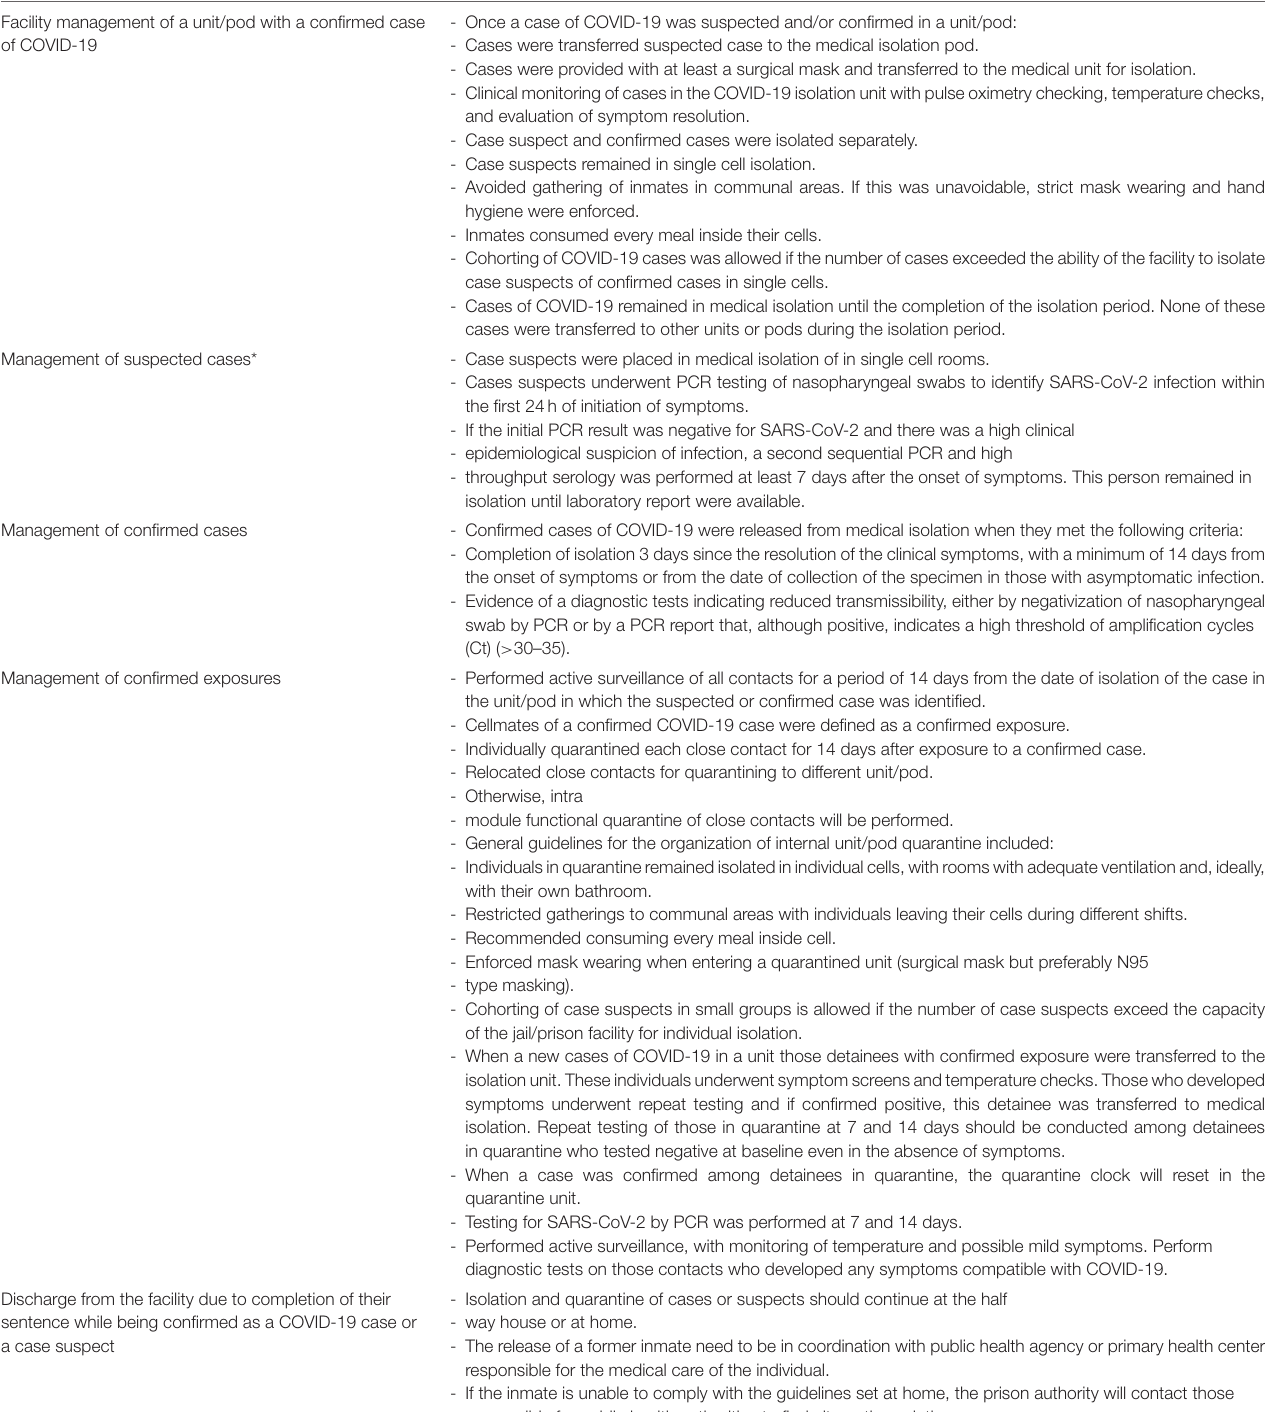
TABLE 3 | Interventions implemented for the management of confirmed cases and close contacts during the COVID-19 outbreak in the CPAII Prison in Alicante, Spain (January-April 2021). Facility management of a unit/pod with a confirmed case - Once a case of COVID-19 was suspected and/or confirmed in a unit/pod: of COVID-19 - Cases were transferred suspected case to the medical isolation pod. - Cases were provided with at least a surgical mask and transferred to the medical unit for isolation. - ClinicalmonitoringofcasesintheCOVID-19isolationunitwithpulseoximetrychecking,temperature checks, and evaluation of symptom resolution. - Case suspect and confirmed cases were isolated separately.